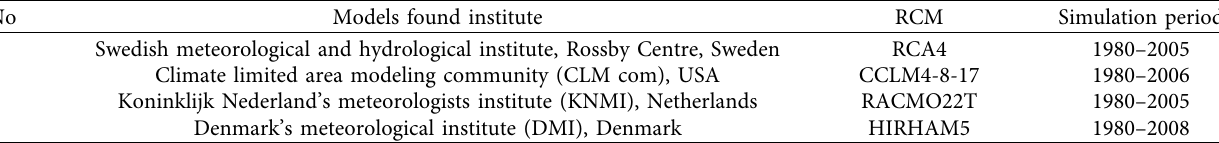
Table 2: Lists of used RCMs with their founding Institutions.